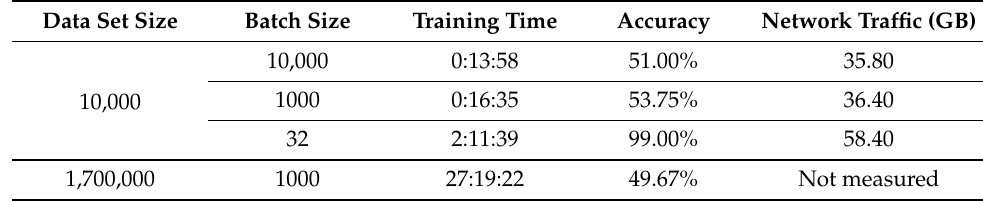
Table 7. Parameters of NN training using MPC for different